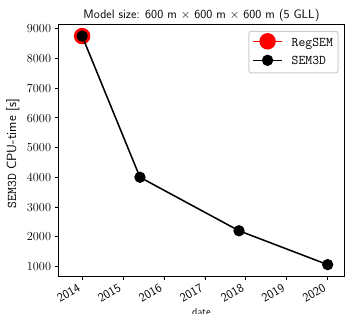
Figure 3. Improvement of SEM3D compared to initial RegSEM version. The values of CPU time refer to the equivalent-mono-core time required to solve a wave-propagation problem in a 600 m 600 m cube, with PML on all sides and 5